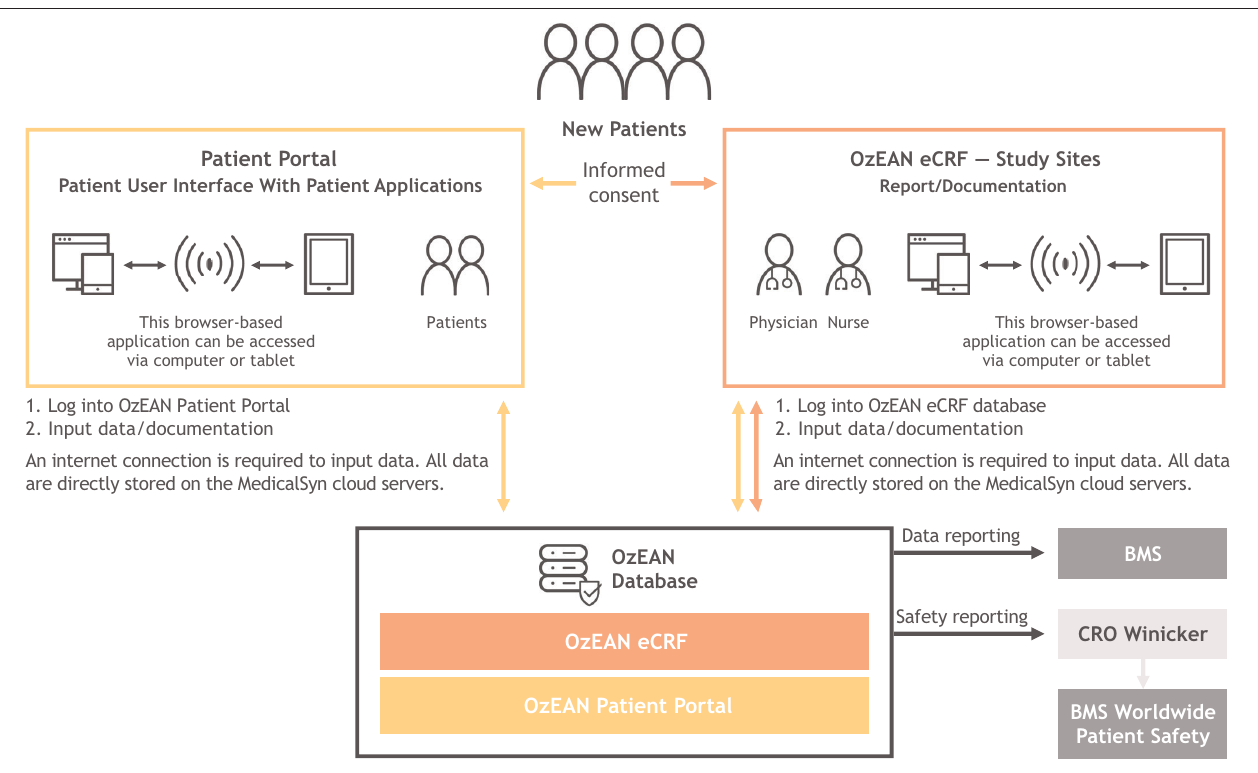
FIGURE 3 | Architecture and data flow within OzEAN eCRF and OzEAN patient portal. Physician-reported assessments are performed at the study site, and data are entered by physicians into the OzEAN eCRF. Patient-reported assessments are completed by patients using the OzEAN patient portal, and data are fed into the OzEAN eCRF. The patient portal interface additionally provides a calendar, medication plan, documents module, and access to surveys (PROs). Data from the OzEAN eCRF are transmitted to Winicker Norimed GmbH (the contract research organization) for storage on secure servers. Data on adverse events are additionally transmitted to the sponsor or its designee as part of standard safety reporting. CRO, contract research organization; eCRF, electronic case report form; PRO, patient-reported outcome.